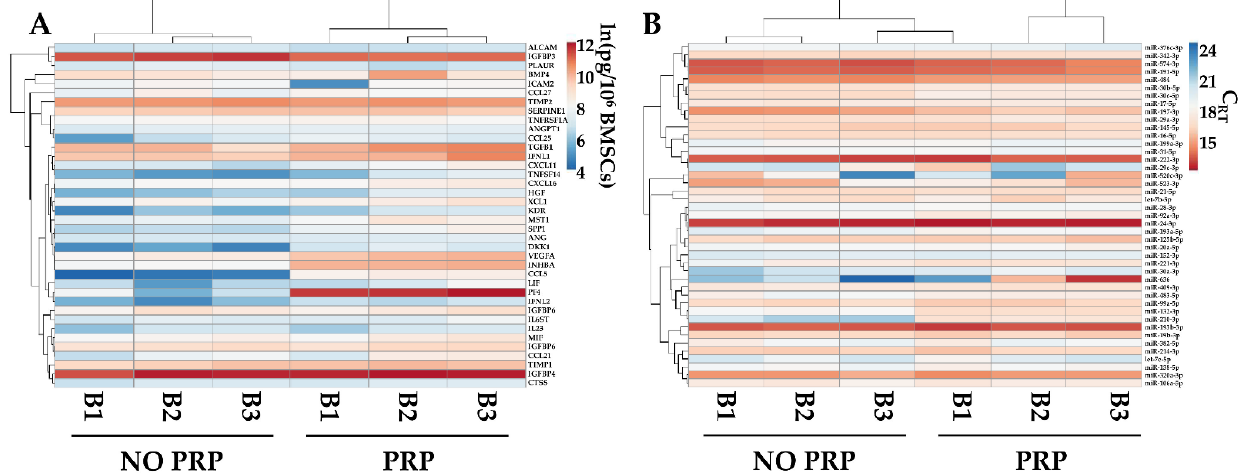
Figure 6. Comparison of abundant PRP-treated BMSCs’ soluble factors (>1 ng/10 6 cells) and EV- miRNAs (in the first quartile of expression), with counterparts obtained from the same isolates and cultured without PRP (NO PRP). Heat map of hierarchical clustering analysis of the ln(x)-transformed pg/million BMSCs values of detected factors ( A ) and normalized C RT values of detected miRNAs ( B ) with sample clustering tree at the top. The color scale reflects the absolute expression levels: red shades = high expression levels and blue shades = lower expression levels.